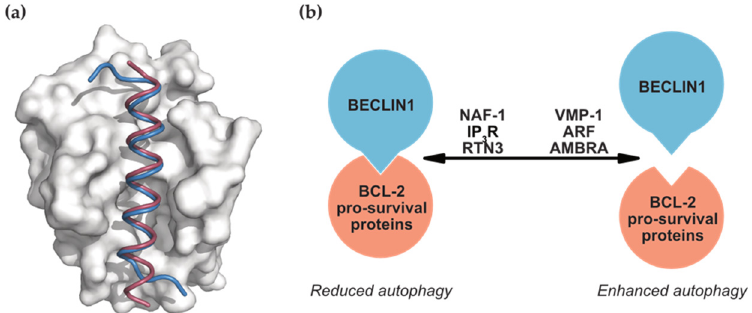
Figure 2. ( a ) Structure of BCL-XL in complex with the BH3 domains of the pro-apoptotic BH3-only protein BIM (blue, PDB: 3FDL) [61] and BECLIN1 (pink, 2P1L) [57]. Both BH3 domains occupy the same binding site. ( b ) Schematic of proteins that competitively bind BECLIN1 and/or BCL-2 to promote or inhibit this interaction, thereby reducing or enhancing autophagy, respectively.